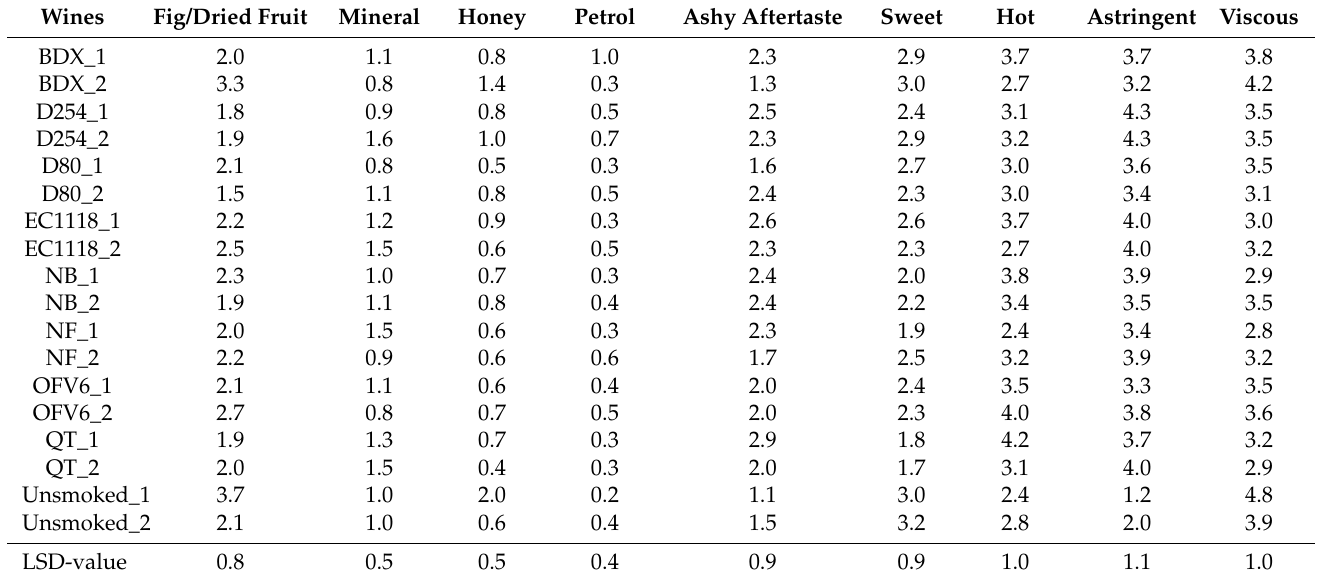
Table 4. Overall means and Fisher’s least significant difference (LSD) for descriptive analysis attributes from panel 1 (n =